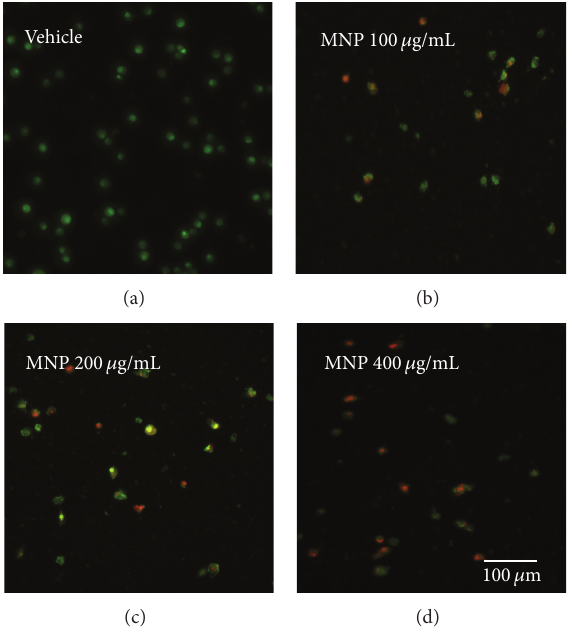
Figure 5: Morphological assessment of MCF-7 cells stained with acridine orange (green) and propidium iodide (red). Cells are incubated with or without 𝛼 -Fe 2 O 3 at various concentrations for 24 h. Cells with intact membrane and stained green indicate viable cells; cells that are stained orange represent secondary necrotic or late apoptotic cells containing fragmented DNA (magnification 100x, scale bar 20 𝜇